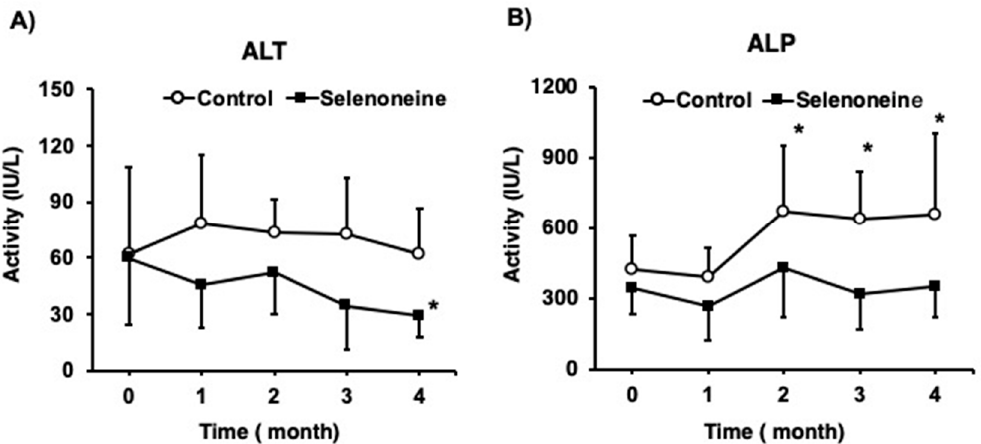
Figure 4. Changes in alanine aminotransferase (ALT) and alkaline phosphatase (ALP) activity. ( A ) ALT activity. ( B ) ALP activity. Mice were supplemented with 0.3-mg Se/kg selenoneine for 4 months. Blood was taken from mouse tail every month. Values are presented as mean ± SD ( n = 8). Significant differences were assessed Dunnett’s test (* p < 0.05 vs. corresponding 0 month mice).